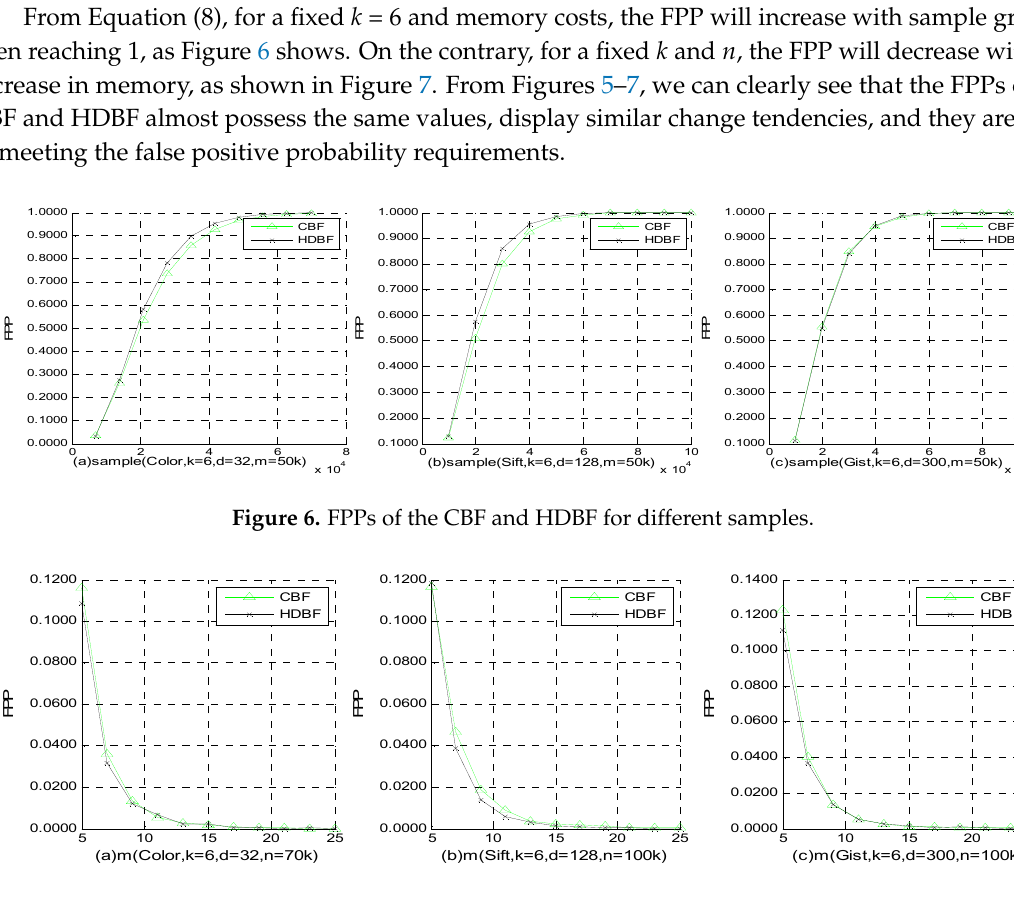
Figure 8. Memory usages of the PBF-BF, PBF-HT, CBF and HDBF with a fixed FPP.